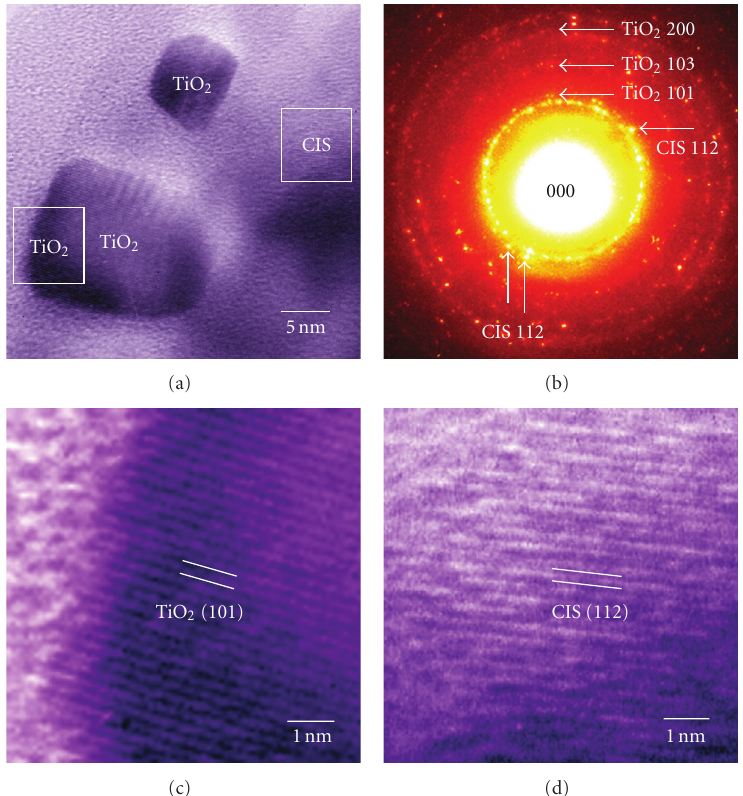
Figure 4: (a) TEM image and (b) electron di ff raction pattern of TiO 2 /CIS structure. (c) Enlarged HREM images of TiO 2 in (a) and (d) CIS in